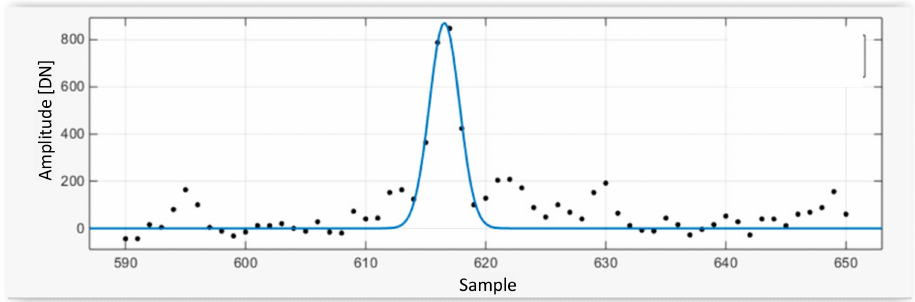
Figure 6. Fitted Gaussian in samples from window (wII) representing second